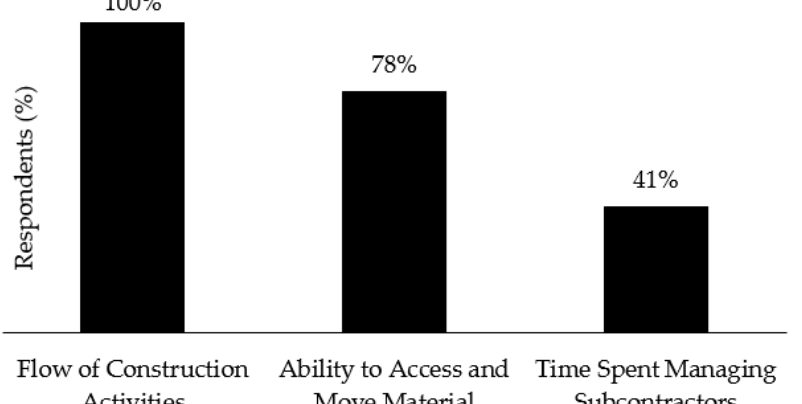
Figure 5. Methods for monitoring SUP effectiveness.